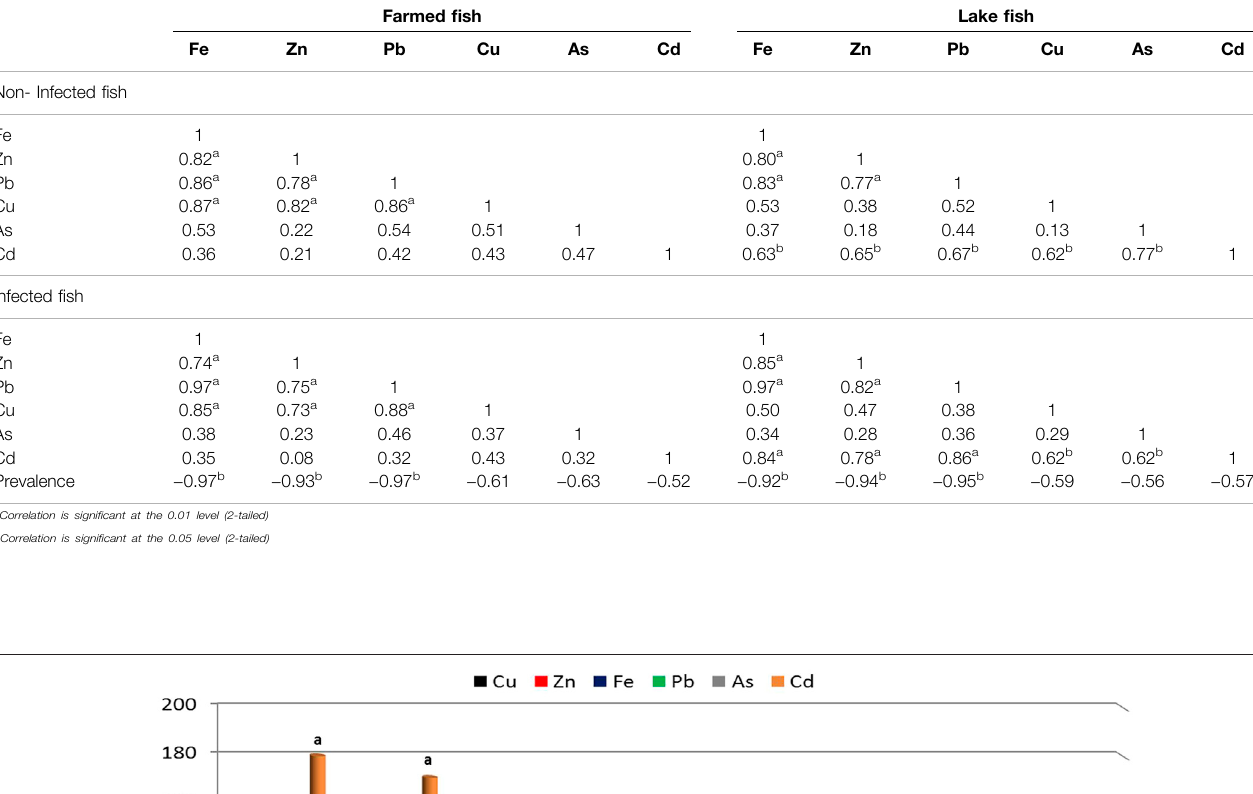
TABLE 8 | Pearson correlations between heavy metal concentrations of lake and farmed in O.